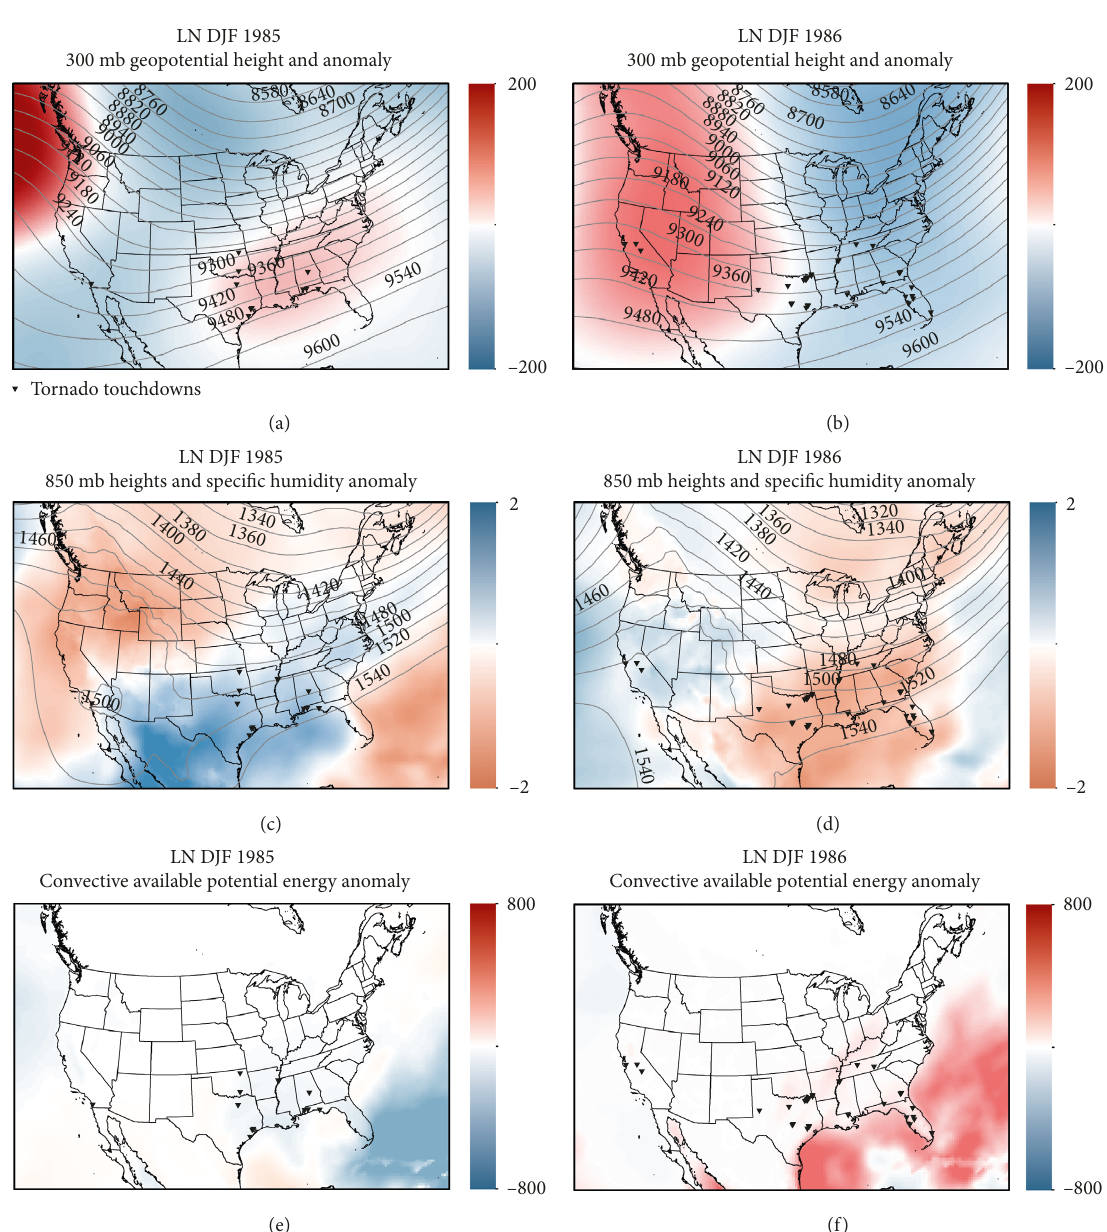
Figure 7: (a, b) 300mb geopotential heights (contours (m)) and anomalies (color (m)), (c, d) 850 mb geopotential heights (contours (m)) and specific humidity anomalies (color (g · kg − 1 )), and (e, f) CAPE anomalies (J · kg − 1 ) for the two anomalously inactive LN